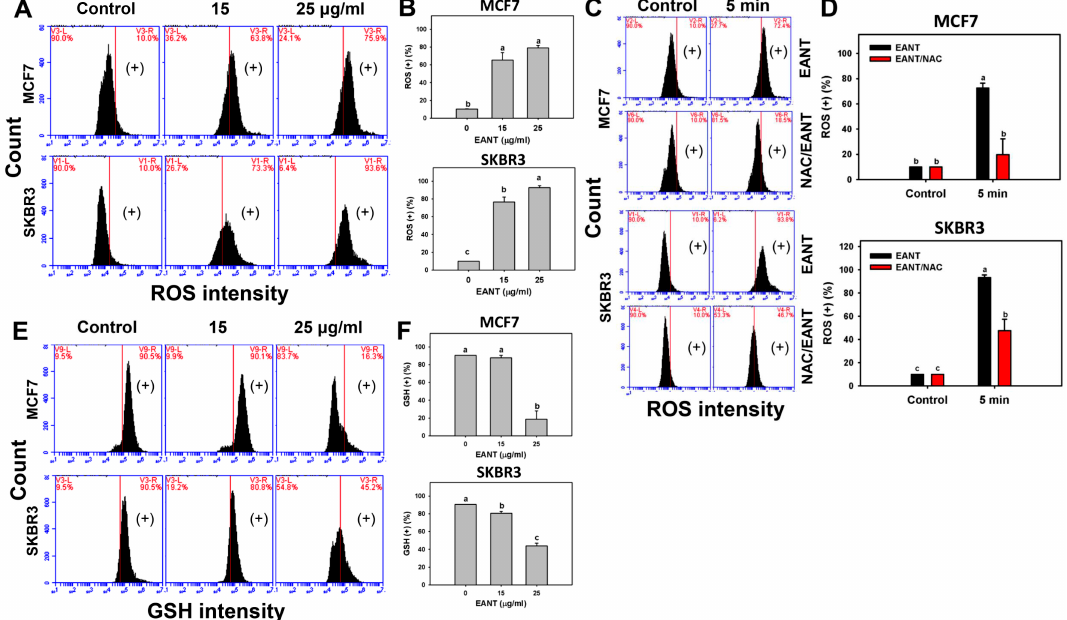
Figure 4. Reactive oxygen species (ROS) and glutathione (GSH) changes after EANT treatment. ( A 165 ( A , B ) Concentration e ff ect of EANT on ROS patterns and statistics. Breast cancer cells (MCF7 and B ) Concentration effect of EANT on ROS patterns and statistics. Breast cancer cells (MCF7 and 166 SKBR3) were treated with control with DMSO only and EANT (15 and 25 μ g/mL) for 5 min. ( C and 167